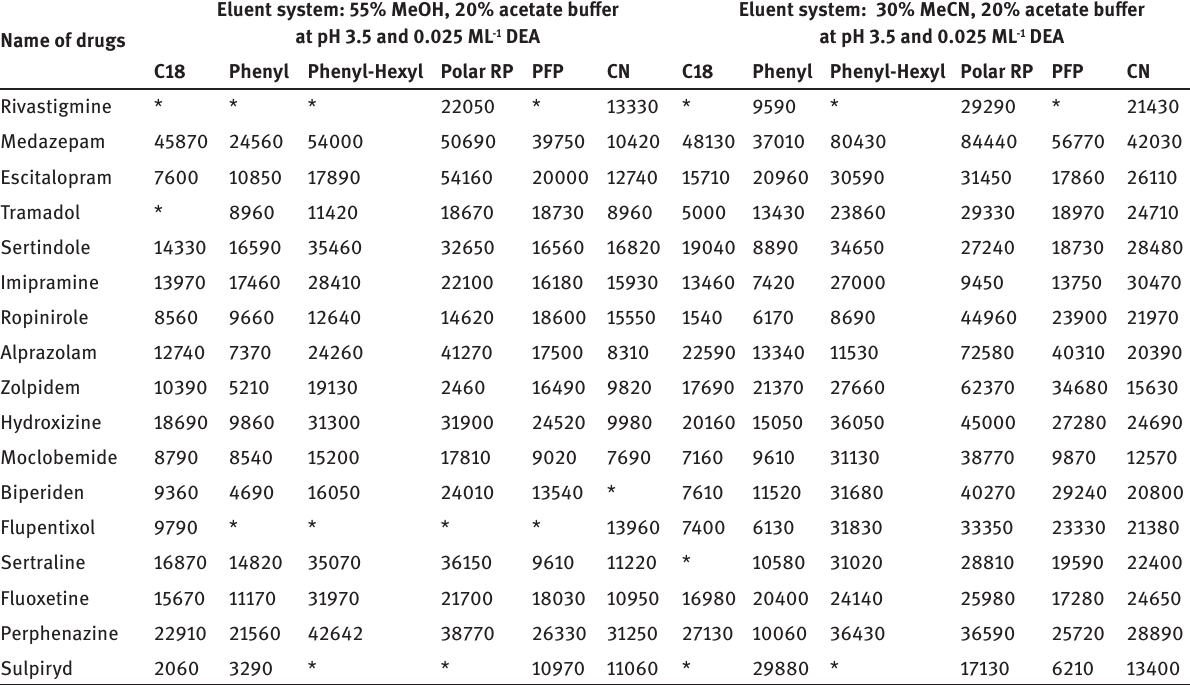
Table 2: N/m values obtained for psychotropic drugs on different columns.